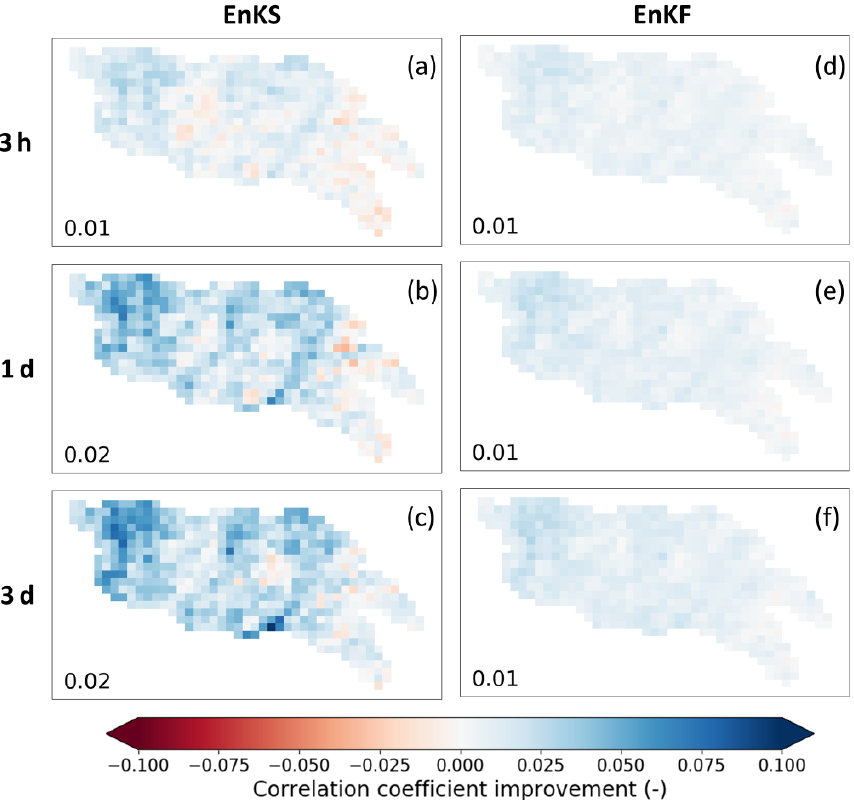
Figure 3. Maps of correlation coefficient improvement after SMART rainfall correction (i.e., improvement of correlation with respect to NLDAS-2 benchmark rainfall realized upon implementation of SMART). Shown in (a–c) are the SMART EnKS experiments, and shown in (d–f) are the EnKF experiments. Each row shows results based on different temporal accumulation periods (i.e., every 3h and every 1 and 3d aggregation, respectively). The number on the lower left corner of each subplot shows the domain-median correlation